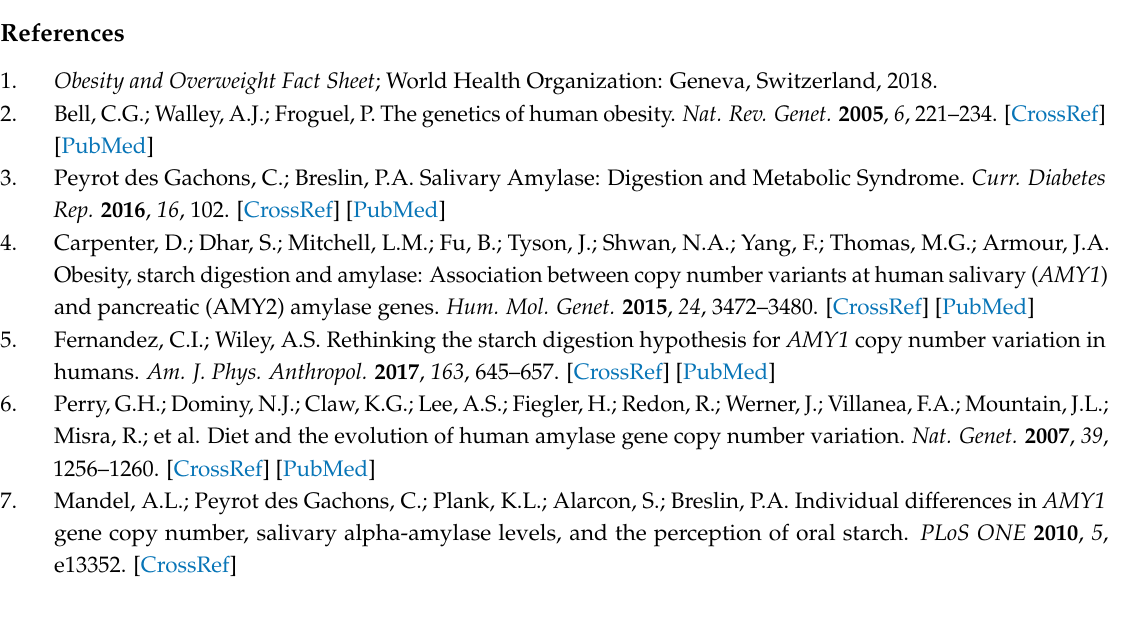
Table S1: Daily macronutrient intake of low and high AMY1 CNV